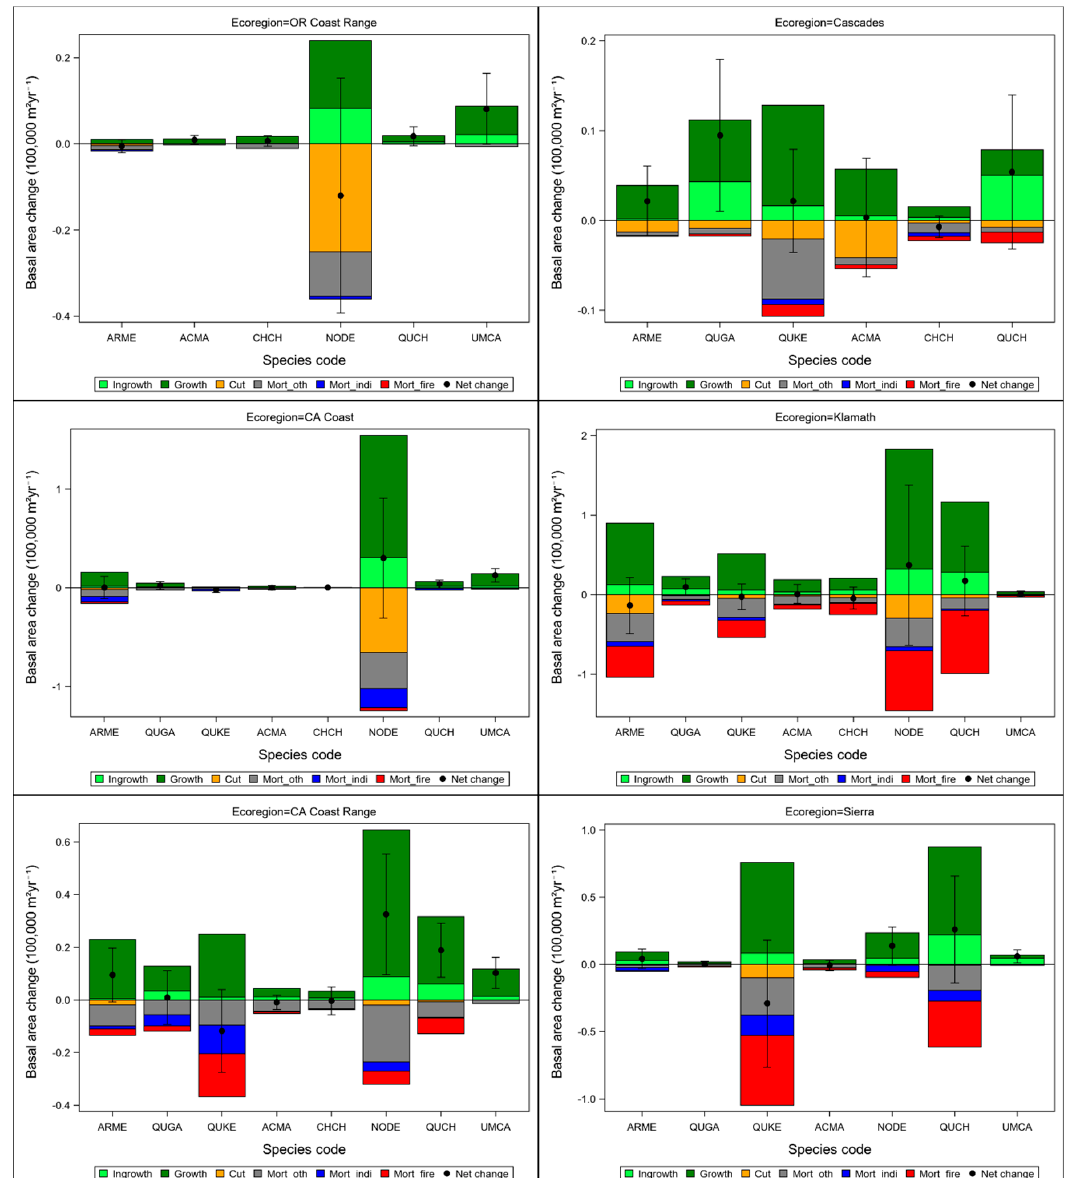
Figure 8. Basal area change by species by ecoregions with net changes shown by points with 95% confidence interval bars. confidence interval